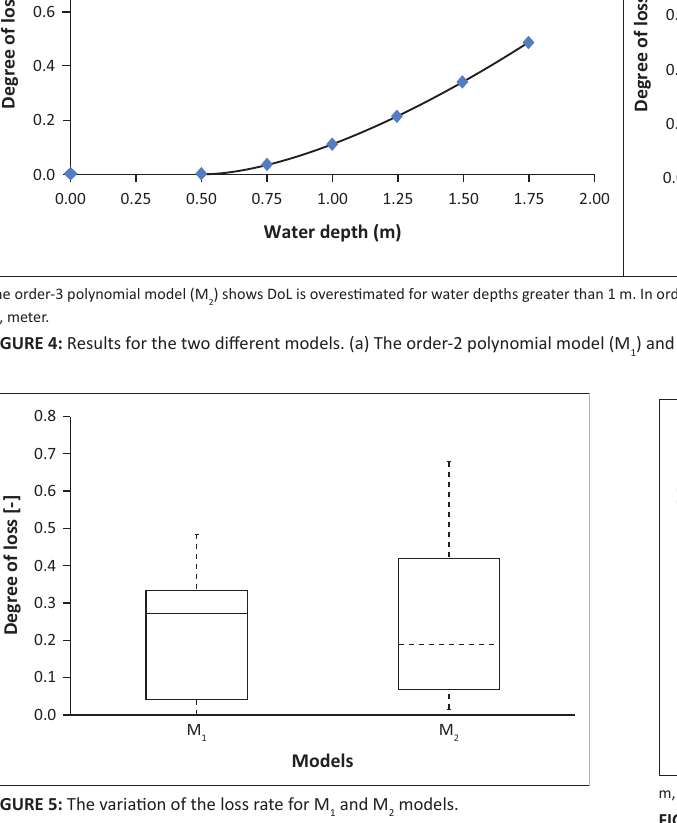
and M models. 1 2